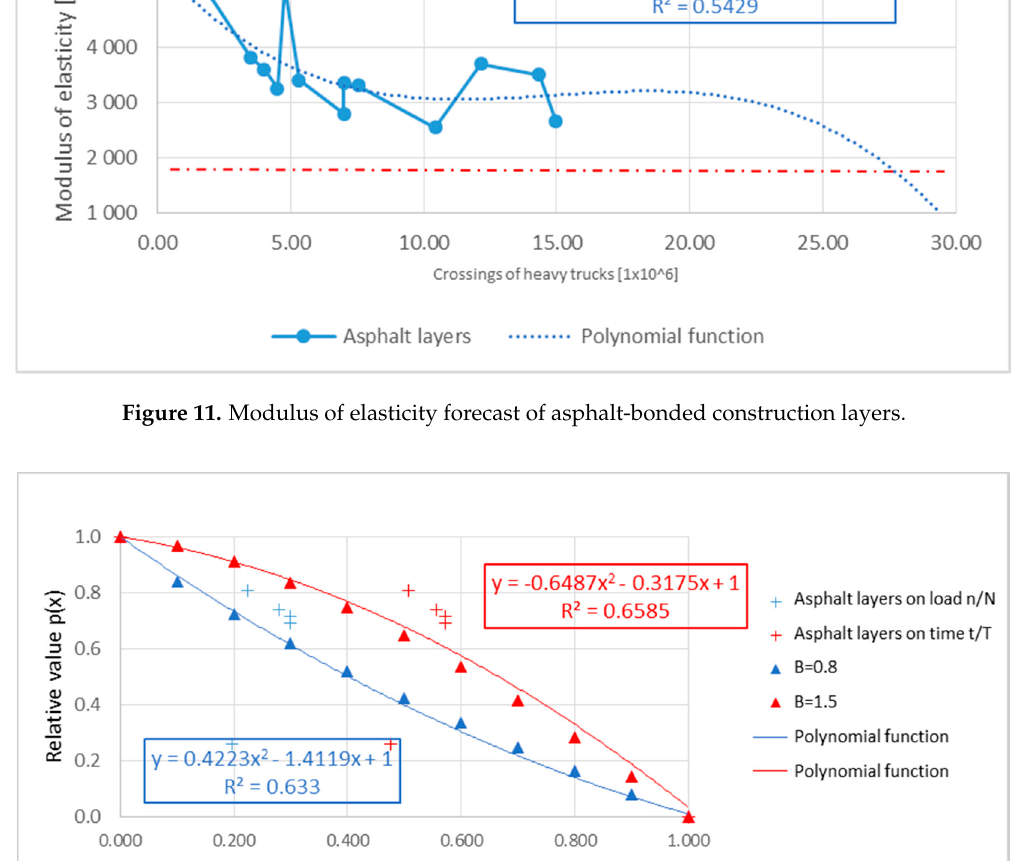
Figure 13. Degradation of the modulus of elasticity depending on the time t/T and load n/N (10.01 –20.00 °C).